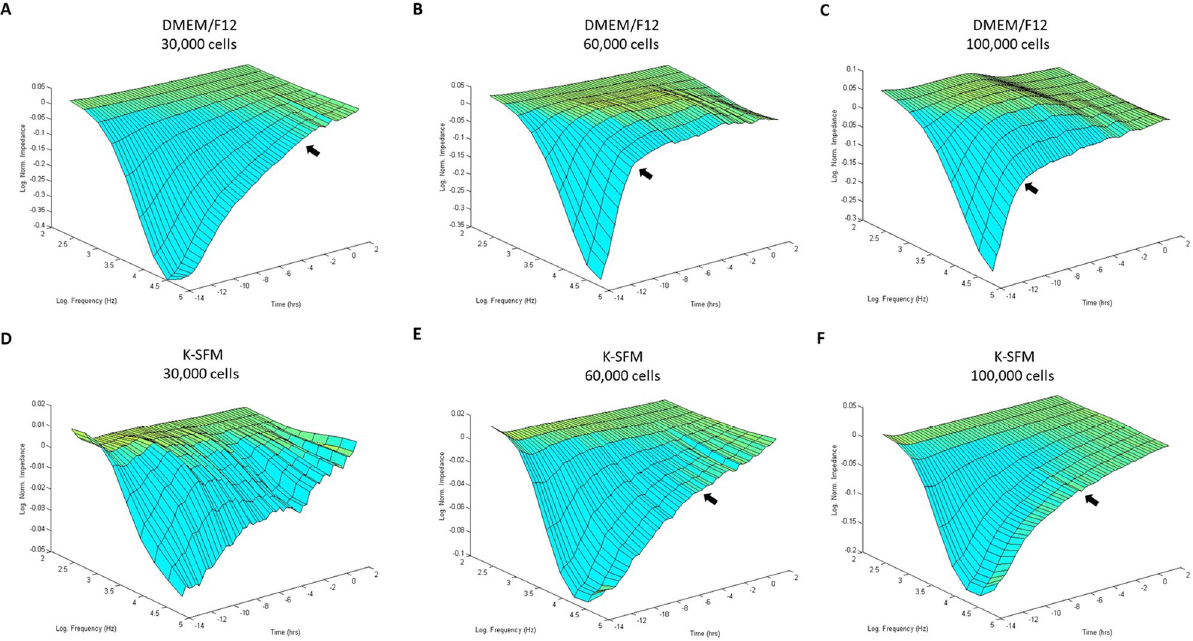
Figure 1. Barrier function of HUCLs monitored by real-time bio impedance analysis using an AC frequency scan. HUCLs were seeded on a 96W1E + ECIS array. Three-dimensional representations of the log of normalized impedance (y-axis) as a function of both log frequency of the alternating-current (AC) (y-axis) and time (z-axis). Cells grown in DMEM/F12 and K-SFM are shown for 30,000 ( A , D ), 60,000 ( B , E ) and 100,000 ( C , F ) cell seeding densities. Arrows indicate start of plateau and approximate time to